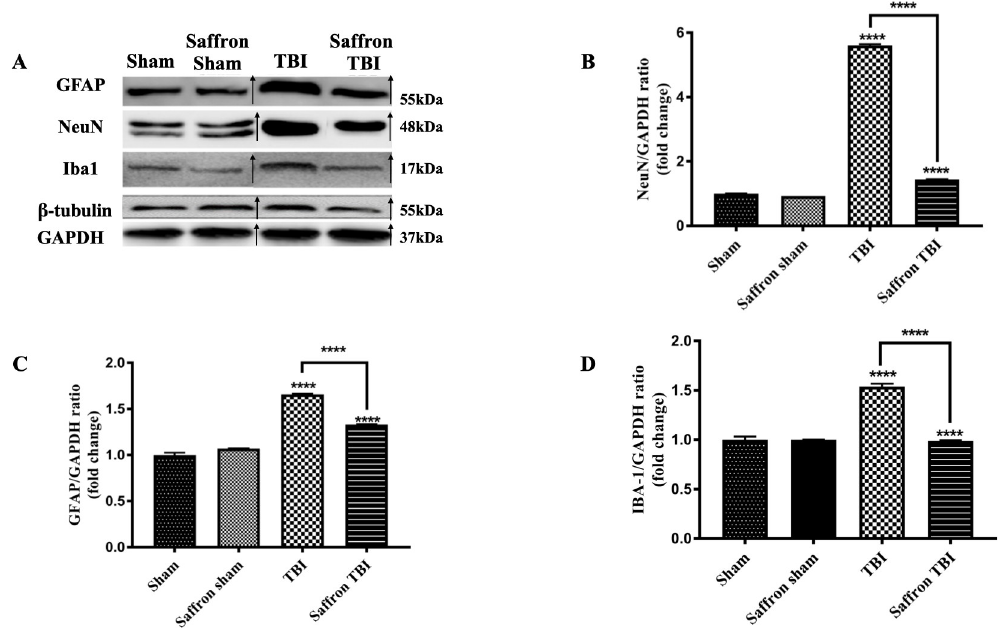
Fig 3. Effect of saffron extract on GFAP, NeuN, Iba1 levels. (A) is a composite representative western blot image of bands originating from different blots for GFAP, NeuN, Iba1, GAPDH, and β –tubulin. The bands of the TBI group and saffron TBI group were spliced from the same original image and re–ordered to be coherent as described in material and methods as samples were loaded differently. The arrow signs show the spliced and rearranged bands. Both β –tubulin and GAPDH were used as a loading control. (B), (C), and (D) show relative bar graphs of NeuN, GFAP, and Iba1 respectively relative to GAPDH 24hours after the final injury. Data are mean ± SEM of 9 mice per group. ( ���� ) represent P < 0.0001.